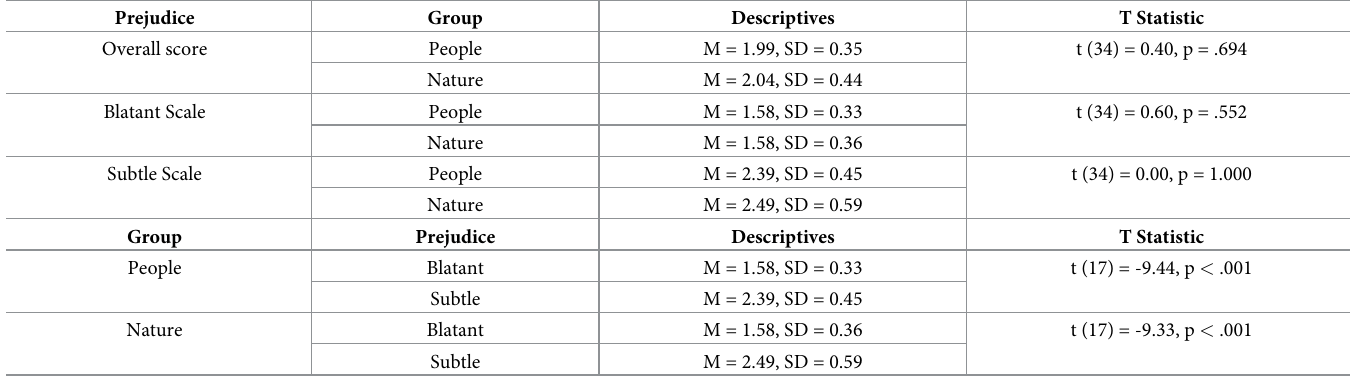
Table 2. Summary of the results of the T-test comparisons on the scores obtained at the Subtle and Blatant Prejudice Scale across the two experimental